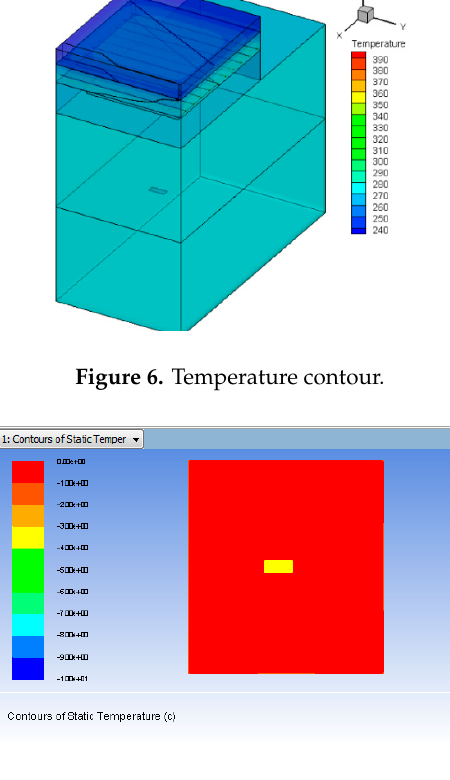
Figure 7. Leaf − air temperature difference.